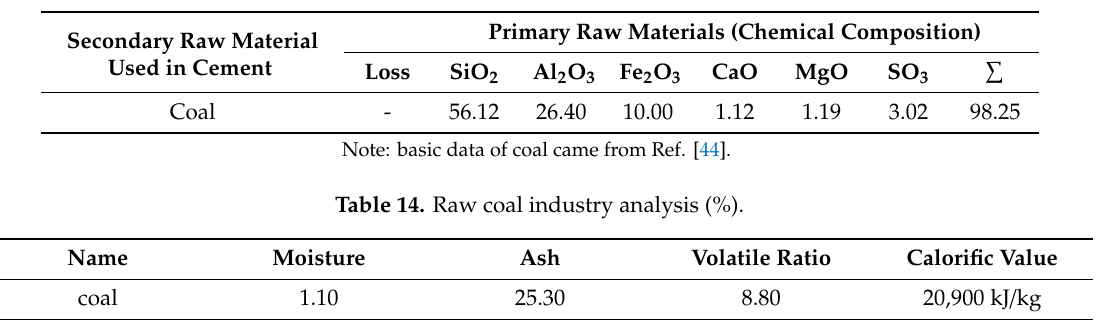
Table 13. Chemical composition of the secondary raw materials: limestone, clay, sandstone, sulfuric acid residue, coal (%).